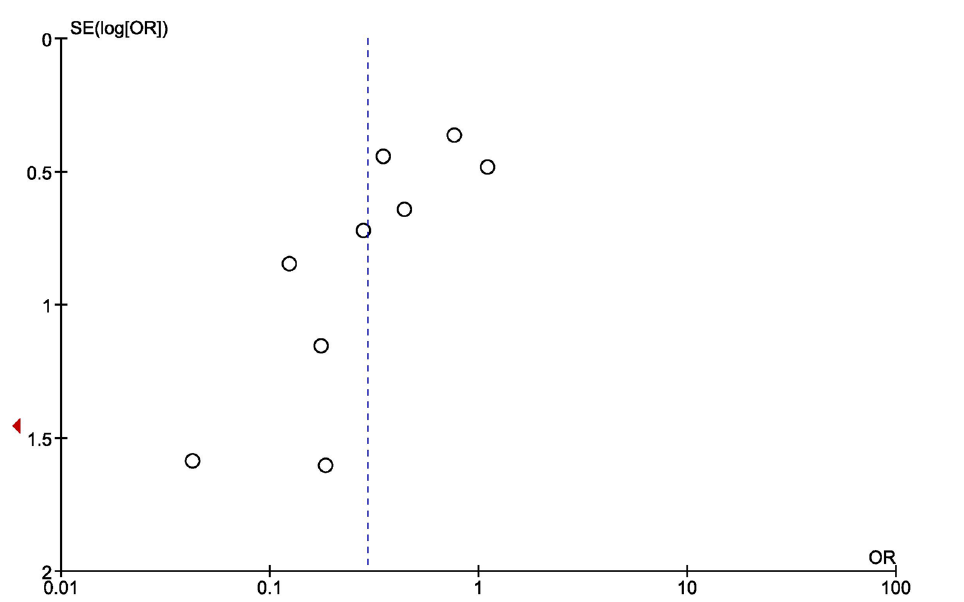
Figure 11. Funnel plot of comparison: Complete Healed Ulcer: HBOT versus